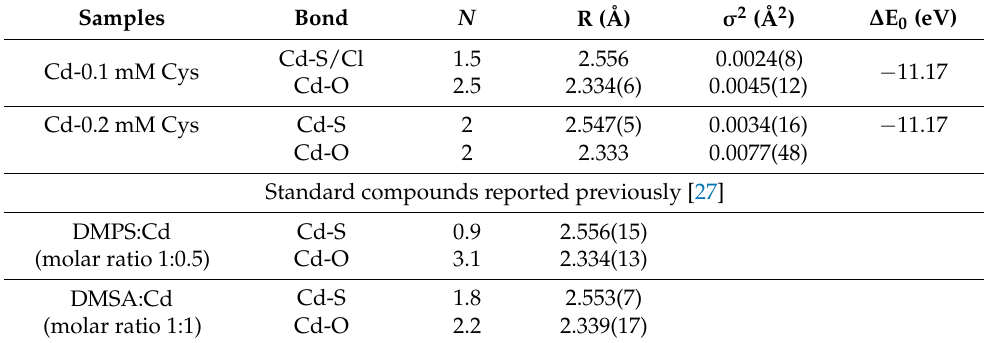
Figure 3. EXAFS spectra ( A ) and corresponding Fourier transforms ( B ) for Cd K-edge for the Cd complex obtained with 100 μ M Cys and the Cd complex obtained with 200 μ M Cys. The Fourier transforms are phase-corrected for the first shell interactions and bond length distances are shown in Table 2. Table 2. Summary EXAFS curve-fitting parameters for Cd compounds.